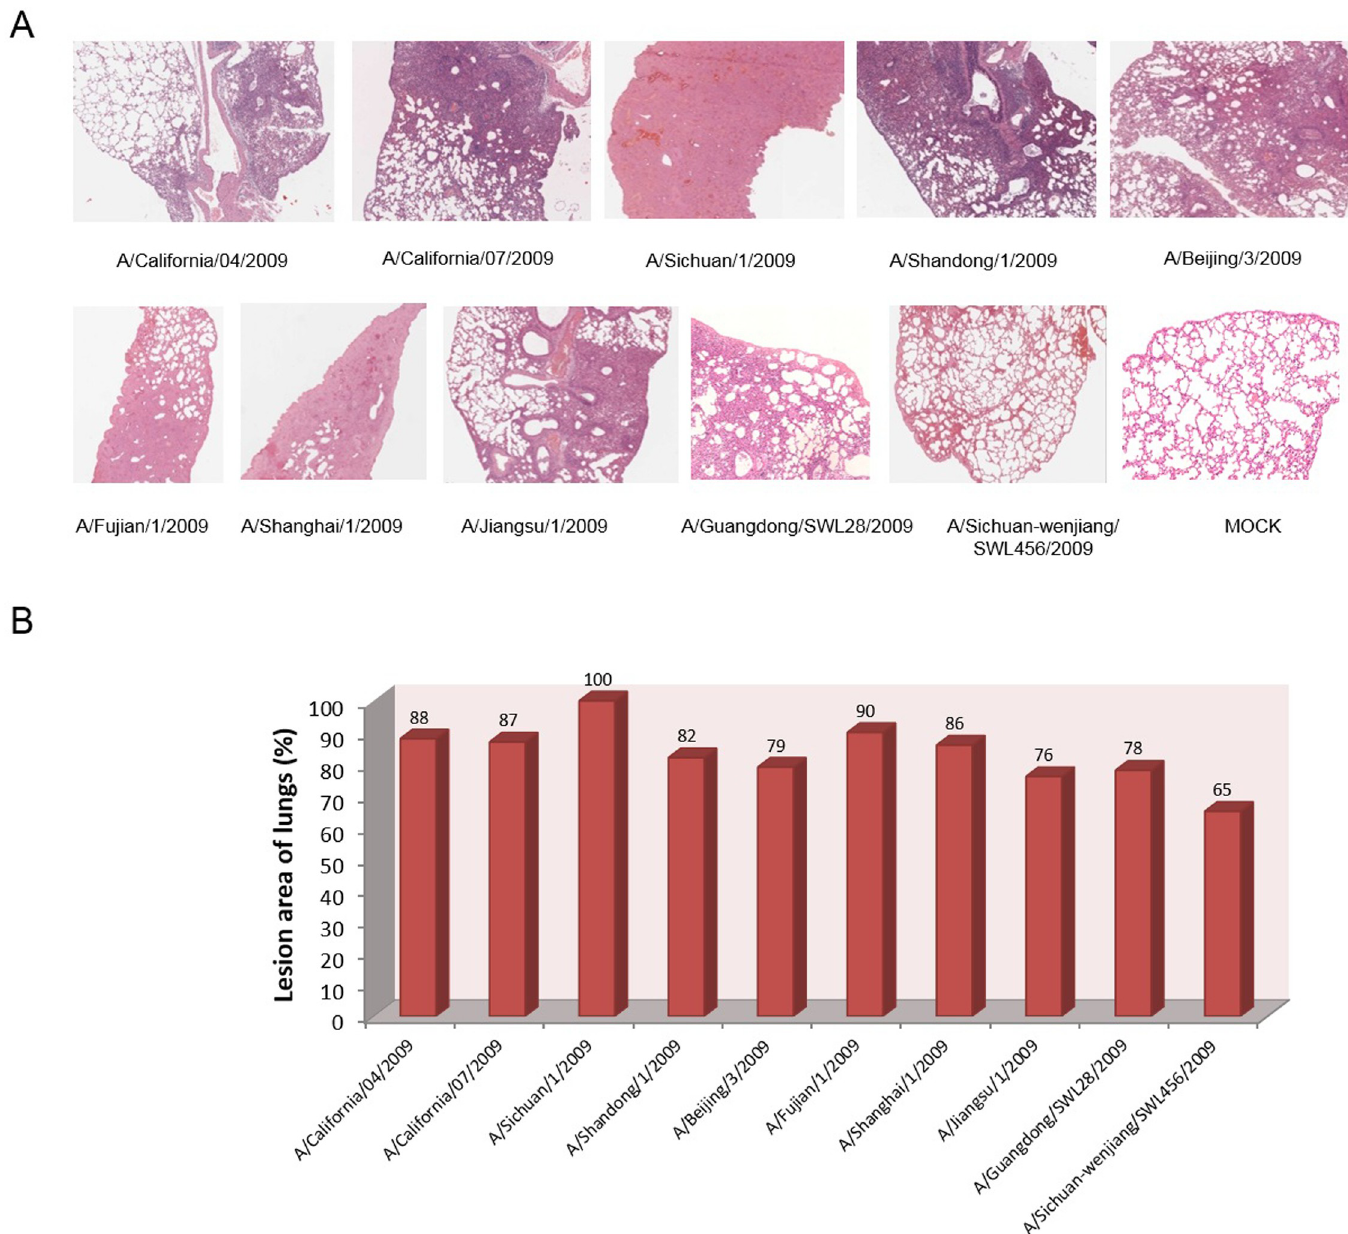
Fig 3. Pathological analysis of the lung tissues of challenged BALB/c mice. Ten mice from each group were euthanized at 5 d.p.i. to obtain lung tissue biopsies, and for each lung three 4- μ m sections were stained with H&E for pathological investigations. (A) Representative sections of H&E stained lung tissues from 10 6 TCID 50 intranasally challenged mice. (B) Percentage of lesion area in lung